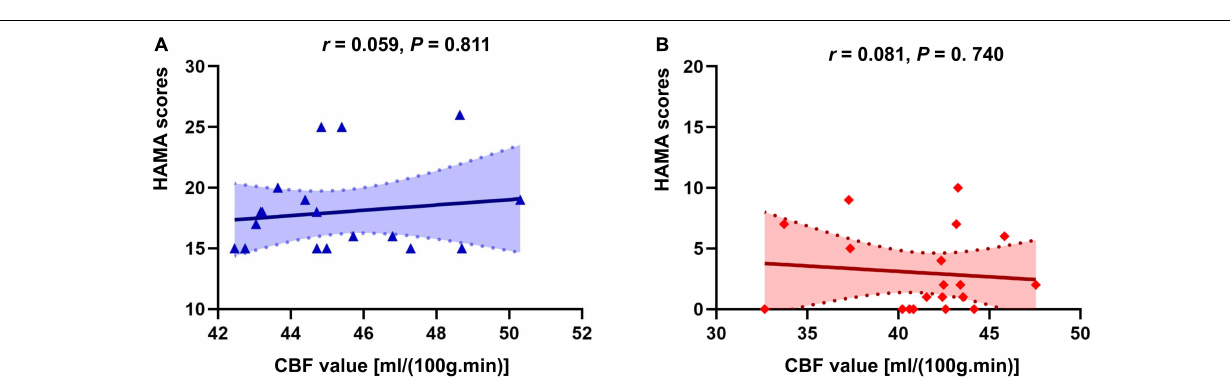
However, the mechanisms of anxiety are quite complex. Lots